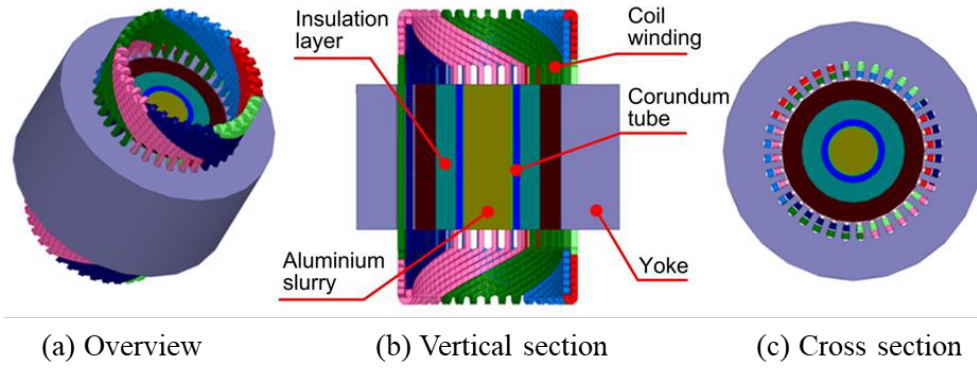
Figure 3. Numerical simulation model of the electromagnetic stirrer. Table 2. Thermophysical parameters of materials in the numerical simulation.